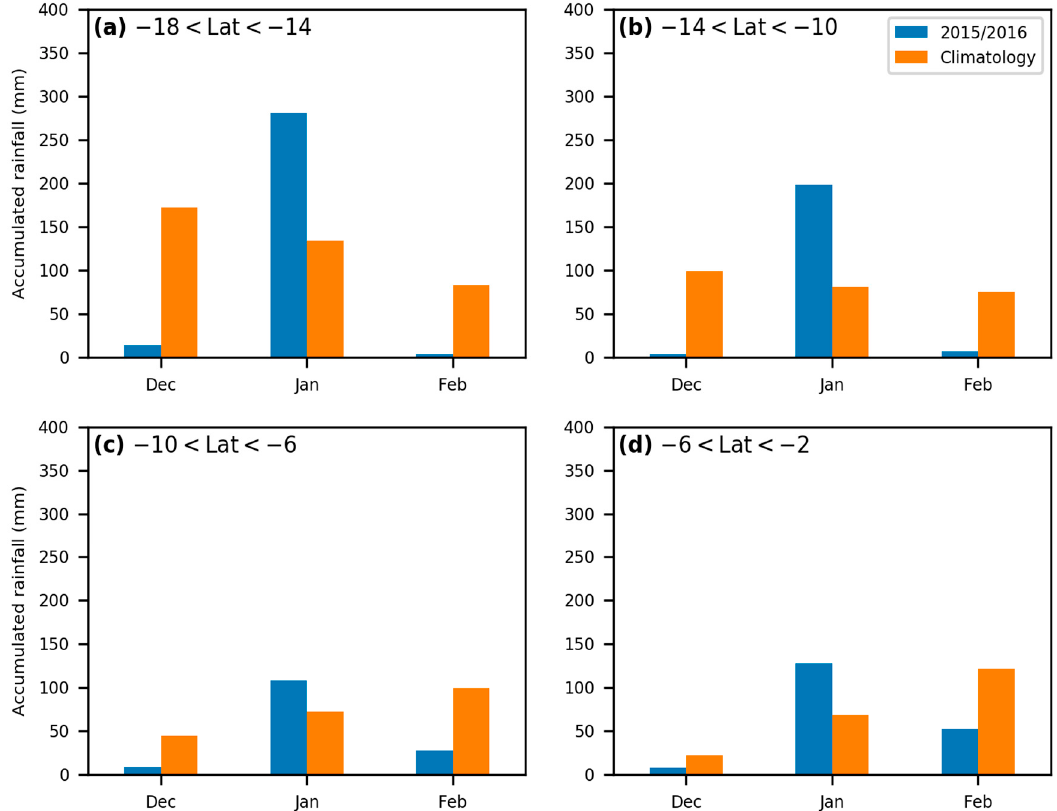
Figure 2. Accumulated rainfall for bands of latitude. Climatological means calculated considering data from each municipality where a station was located: ( a ) − 18 < Lat < − 14, ( b ) − 14 < Lat < − 10, ( c ) − 10 < Lat < − 6 and ( d ) − 6 < Lat < − 2.